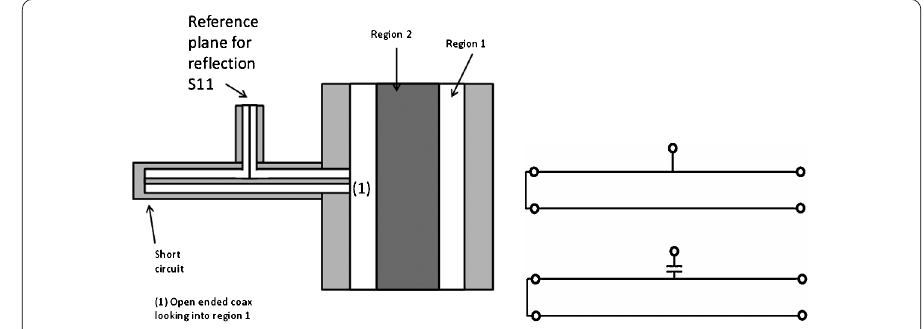
Figure 2 Model of the open ended galvanic coupled quarter-wave coaxial resonator with connected flush to a waveguide pipe section is presented on the left. Schematic circuits of galvanic and capacitive coupled quarter-wave resonators are shown on the